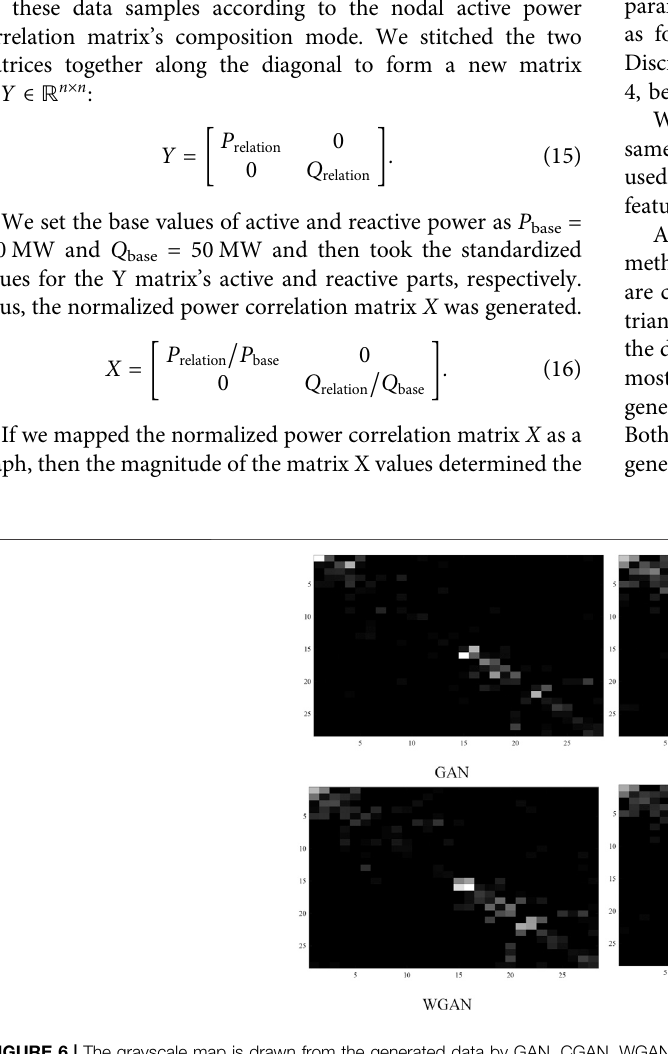
Frontiers in Energy Research |